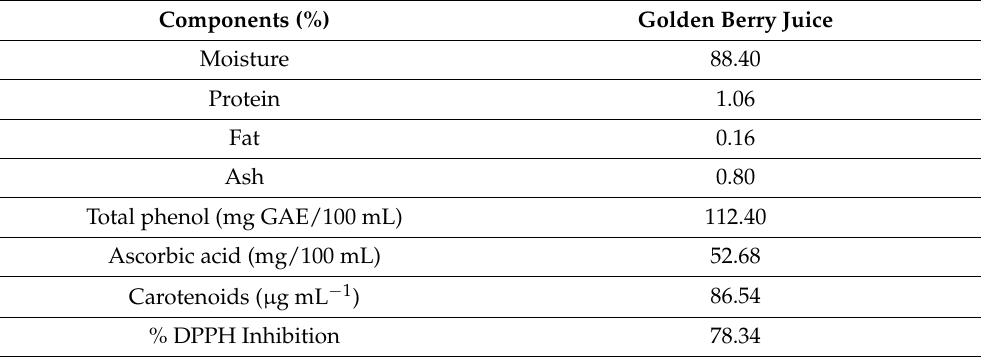
Table 1. Approximate chemical composition (total phenol, ascorbic acid, and carotenoid content) and % DPPH inhibition of golden berry